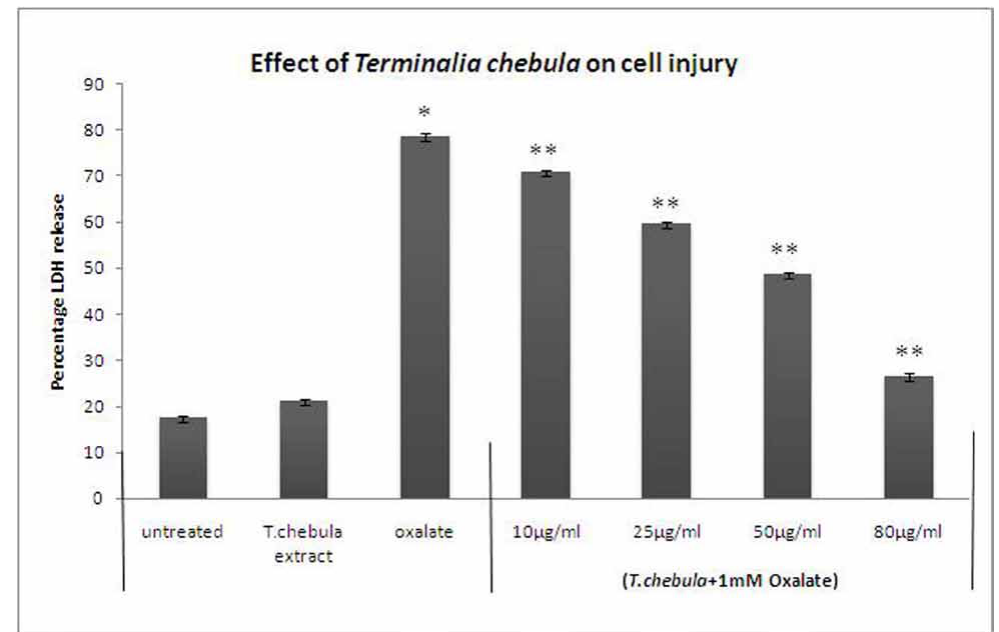
Figure 5 – Effect of Terminalia chebula on the % LDH release of MDCK. Data are mean ± S.D. of three independent observations. * p < 0.05 versus untreated control, ** p < 0.05 versus oxalate